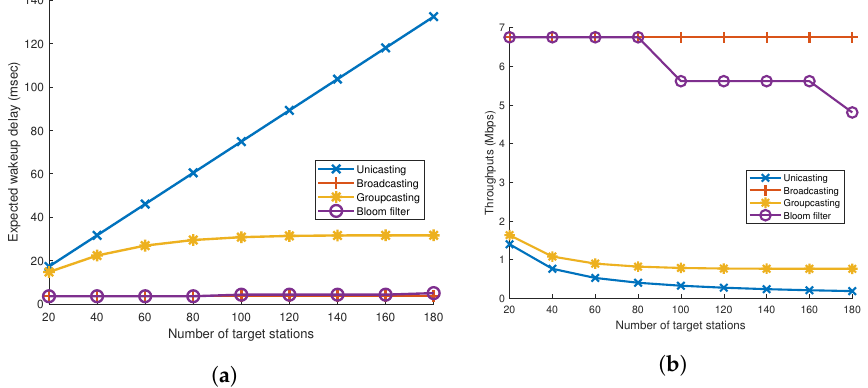
Figure 7. ( a ) Expected wake-up delay and ( b ) average data throughput according to the number of target